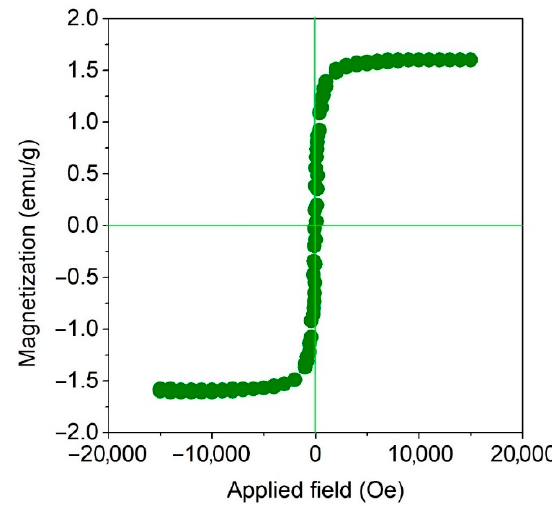
Figure 3. Vibrating sample magnetometer ( VSM) curve of EG@MnFe 2 O 4.